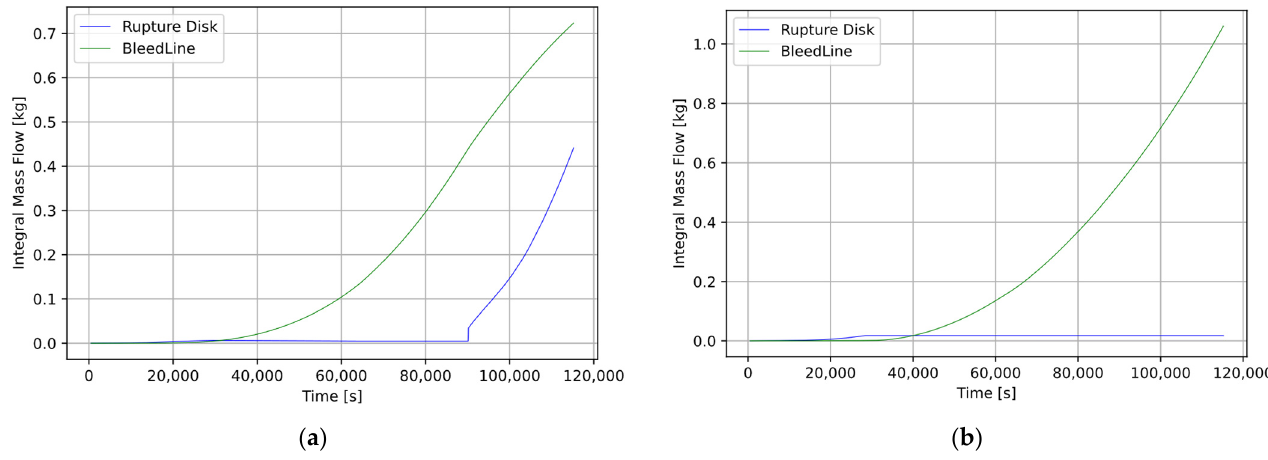
Figure 18. H2 mobilization from VV to connected CV for PIE1 ( a ) and PIE2 ( b ) cases.